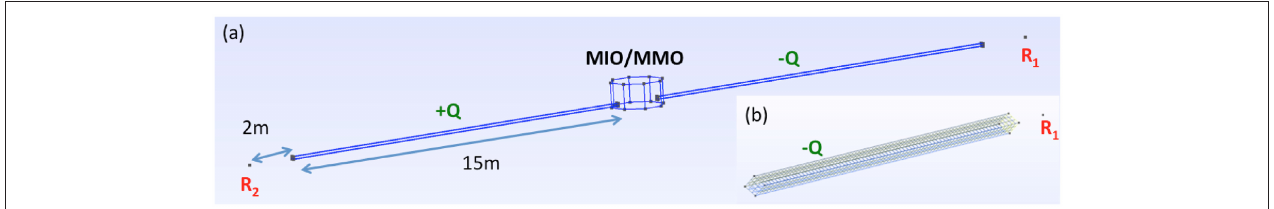
FIGURE 5 | (a) AM 2 P geometry consists on two 15 m-antennas on both sides of the MMO spacecraft with two receivers, R 1 and R 2 , located at 2 m of each end of booms, (b) example of the meshing of one AM 2 P